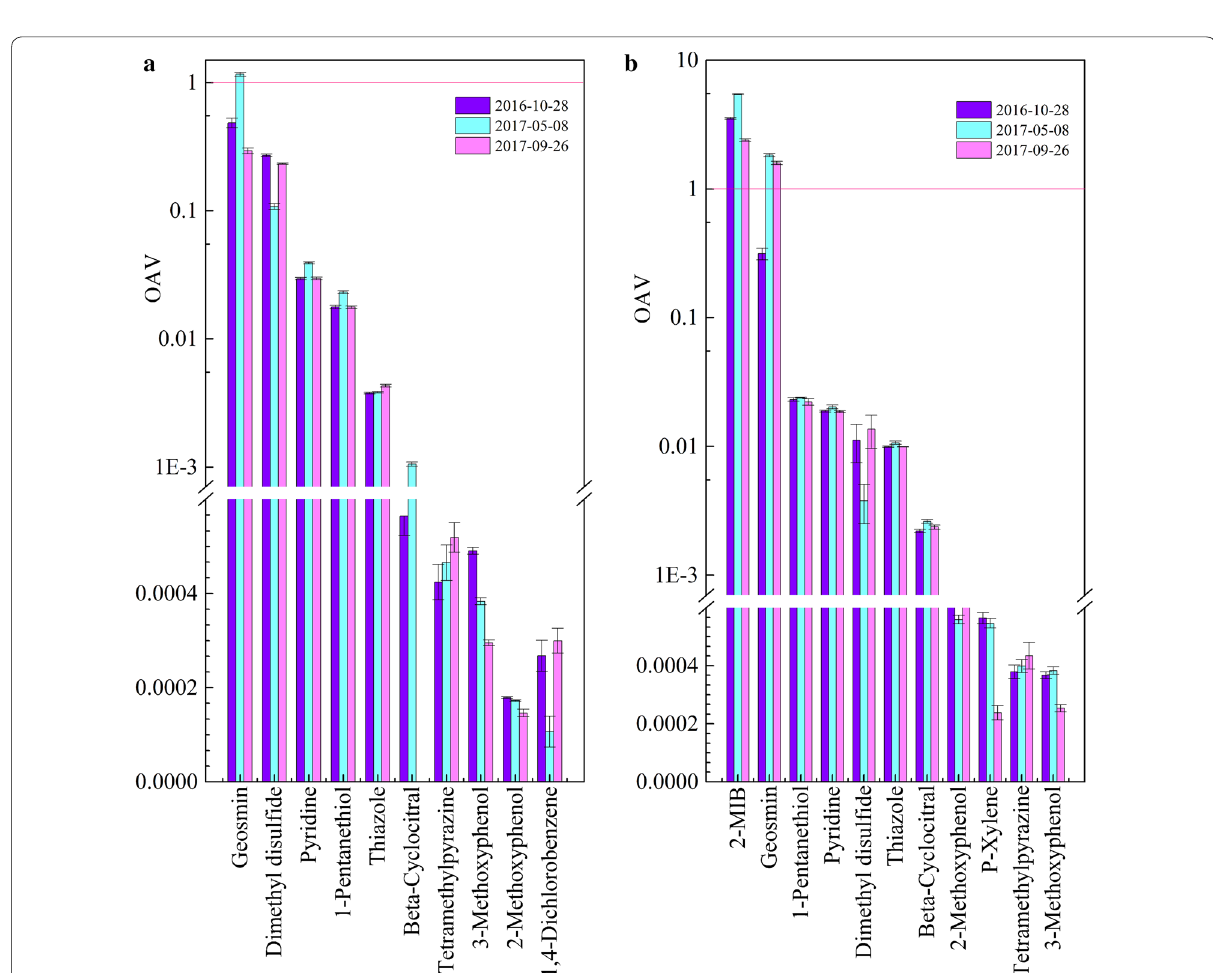
Fig. 2 OAV ranking of the detected odorants in two reservoirs: a Shenzhen reservoir, b Shiyan